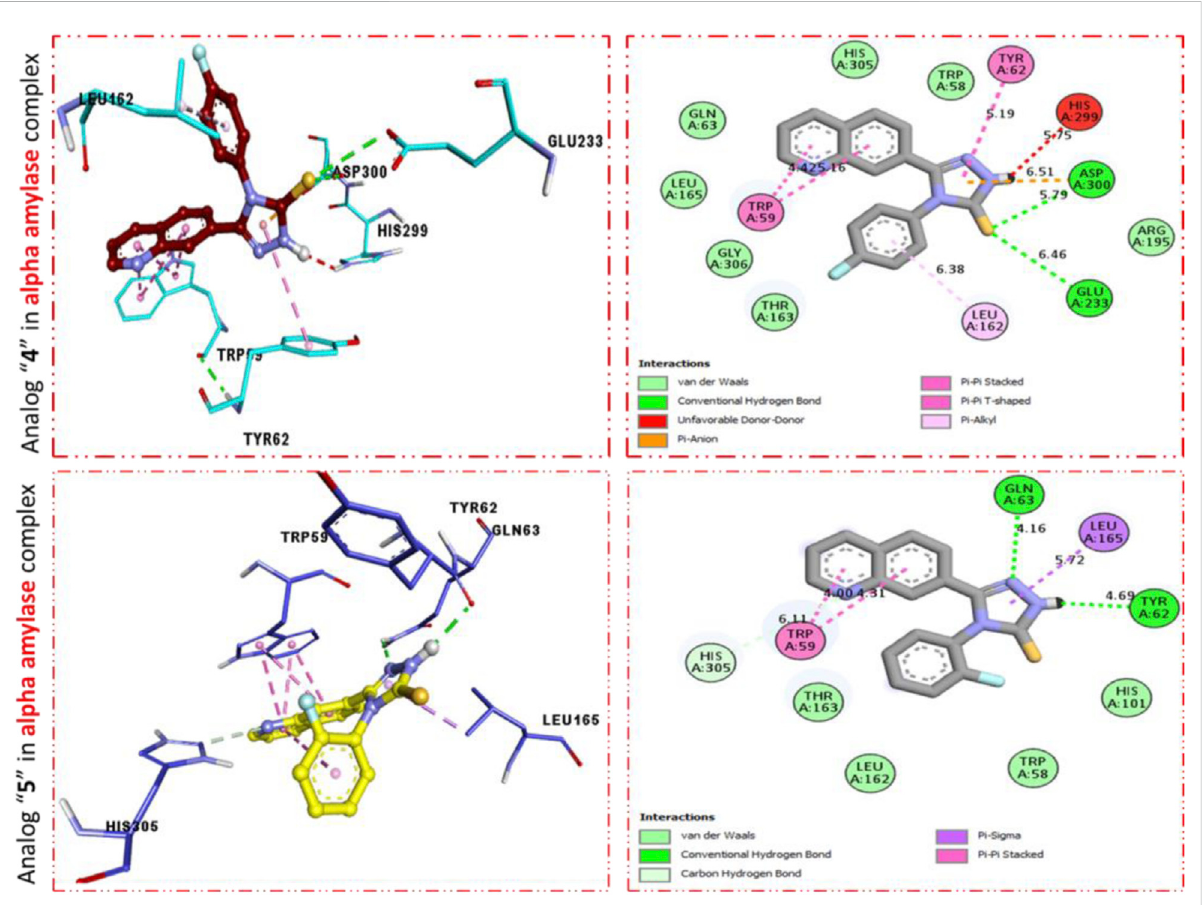
FIGURE 3 PLI pro fi le indicates the corresponding surface of α -amylase enzyme and its interactions with fl uoro-substituted scaffolds 11 d and